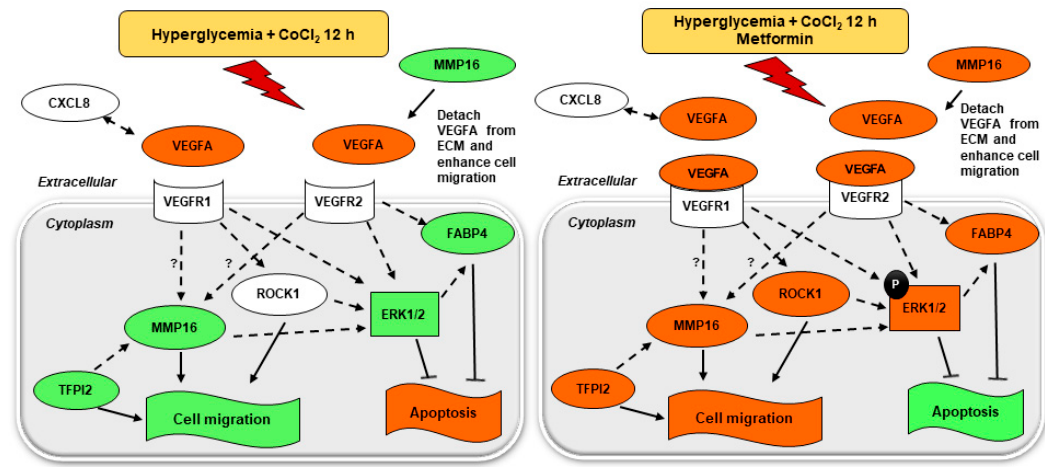
Figure 8. Comprehensive VEGF signaling network of genes and proteins involved in cell migration and survival. Metformin-treated condition is compared to metformin-untreated condition under hyperglycemia-CoCl 2 for 12 h. The network was created by IPA software rendering VEGF signal transduction pathways. The genes from microarray expression study that are represented with red shades are upregulated, and green shades are downregulated, MMP16 was validated by qRT-PCR. The activity of ERK1/2 was assessed by MAPK activation dual detection assay flow cytometry. The red shade on functional assays denoted activation while green shade inhibition. Solid lines denoted direct interaction; interrupted lines denoted indirect interaction.